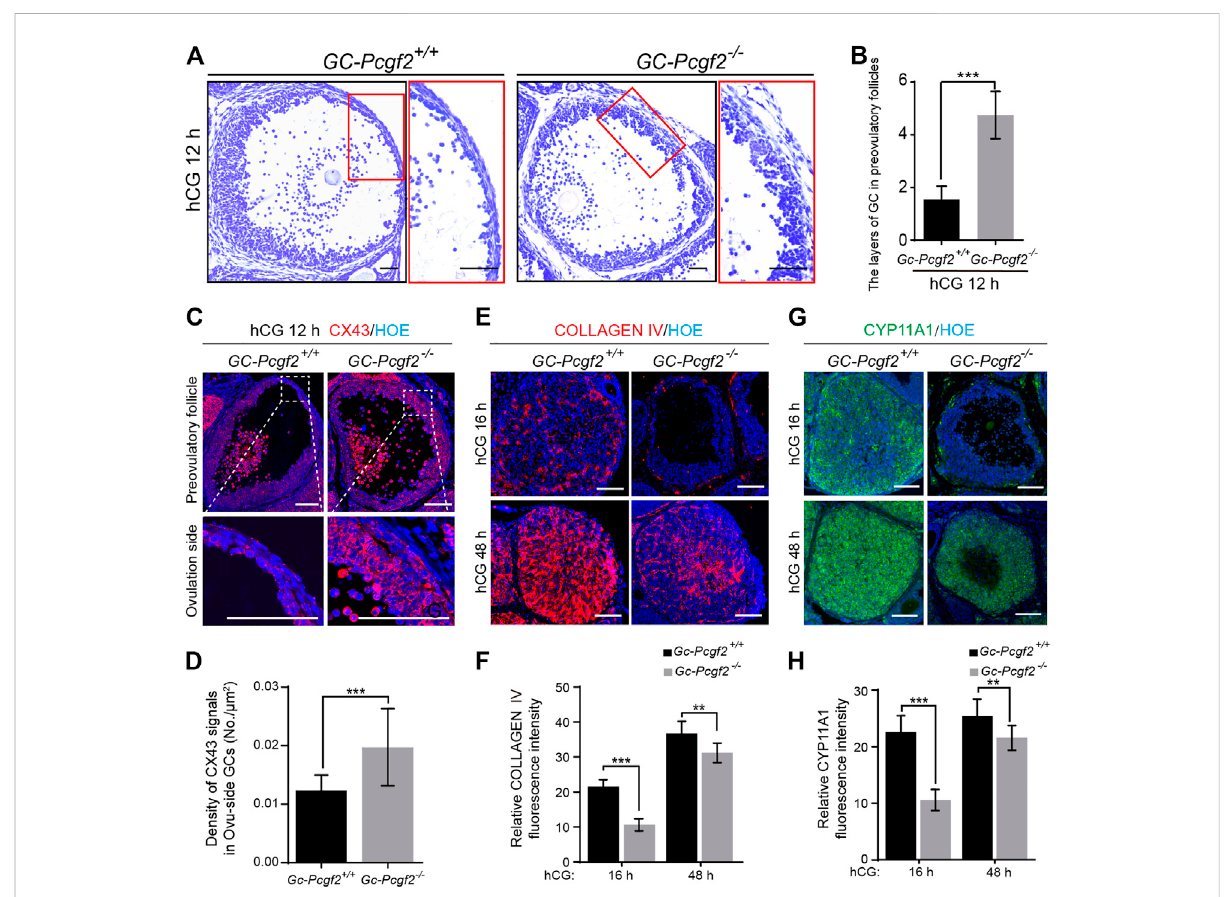
FIGURE 4 Deletion of Pcgf2 in granulosa cells leading to follicular rupture fail and corpus luteum formation delay. (A) Histological analysis showing a thicker GC layer in ovulated-side (Ovu-side) of GC-Pcgf2 − / − preovulatory follicles at hCG 12 h. Scale bars: 50 µm. (B) Statistical analysis result showing more layers of GC in Ovu-side of GC-Pcgf2 − / − (5 ± 1) compared with that of the controls (2 ± 0; n = 40 per group). (C) Immunostaining showing decreased density of CX43 signals in Ovu-side GCs of GC-Pcgf2 − / − compared with that of the controls. Red: CX43; Blue: Hoechst. Scale bars: 100 µm. (D) Quantitative analysis result showing the decreased density of CX43 signals in Ovu-side GCs of GC-Pcgf2 − / − compared with that of the controls ( n = 27 per group). (E) Immunostaining analysis result showing decreased expression of COLLAGEN IV in CLs of GC-Pcgf2 − / − compared with that of the controls. Red: COLLAGEN IV; Blue: Hoechst. Scale bars: 100 µm. (F) Quantitative analysis result showing decreased fl uorescence intensity of COLLAGEN IV in CLs of GC-Pcgf2 − / − compared with that of the controls (hCG 16 h: n = 9 per group; hCG 48 h: n = 7 per group). (G) Immunostaining analysis result showing decreased expression of CYP11A1 in CLs of GC-Pcgf2 − / − compared with that of the controls. Green: CYP11A1; Blue: Hoechst. Scale bars: 100 µm. (H) Quantitative analysis result showing decreased fl uorescence intensity of CYP11A1 in CLs